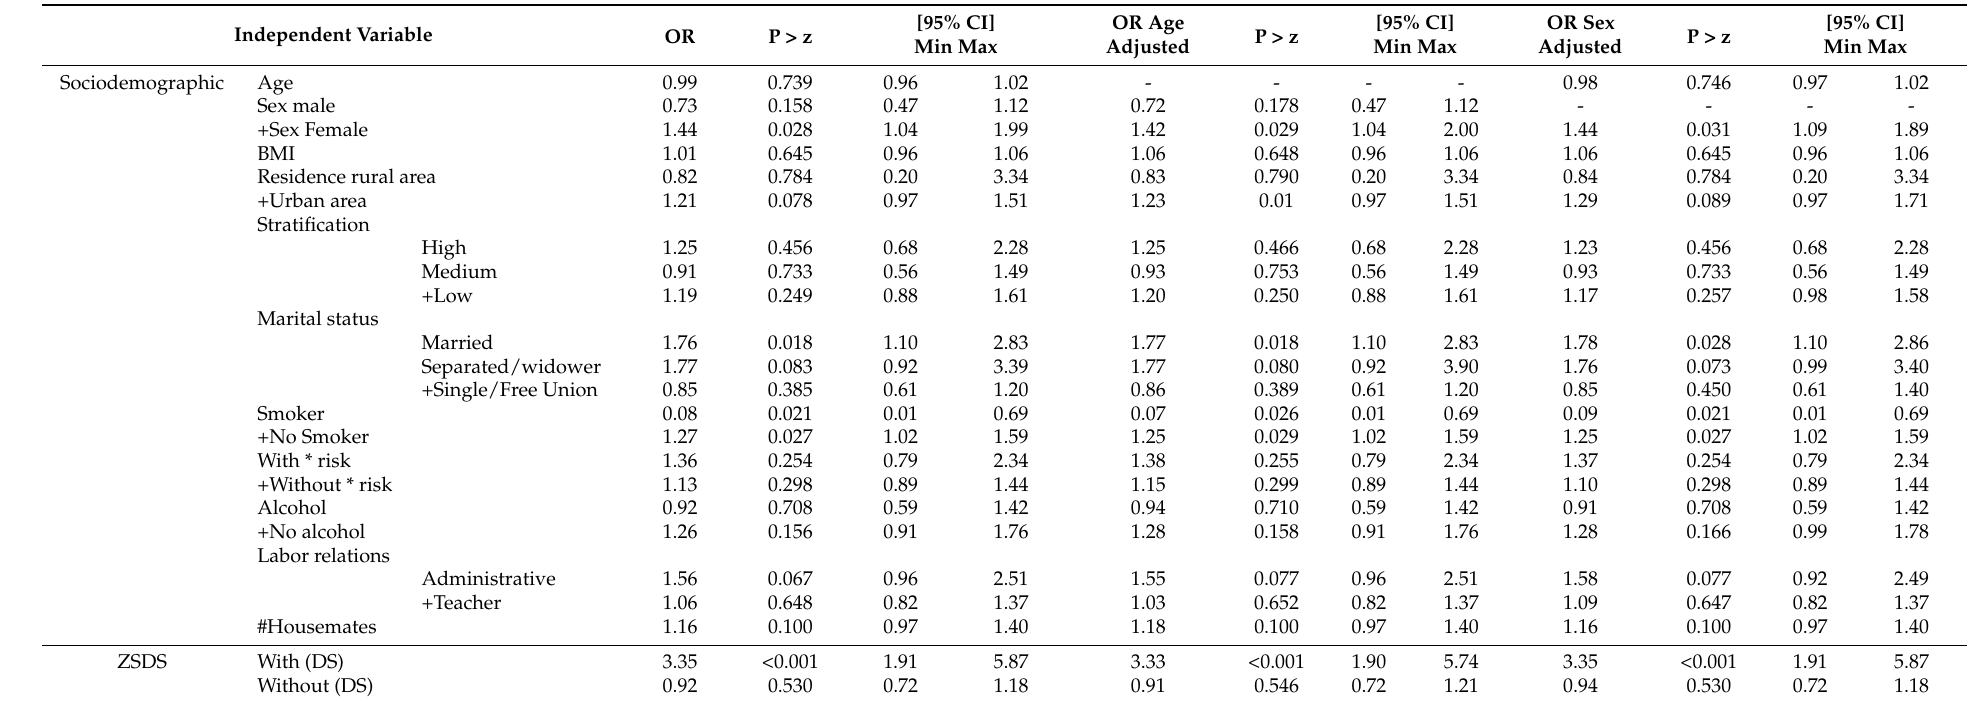
Table 2. Differences of means according to the level of physical